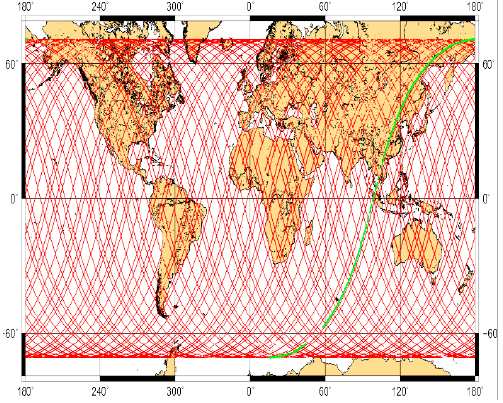
Figure 1. Global scheme of satellite tracks.